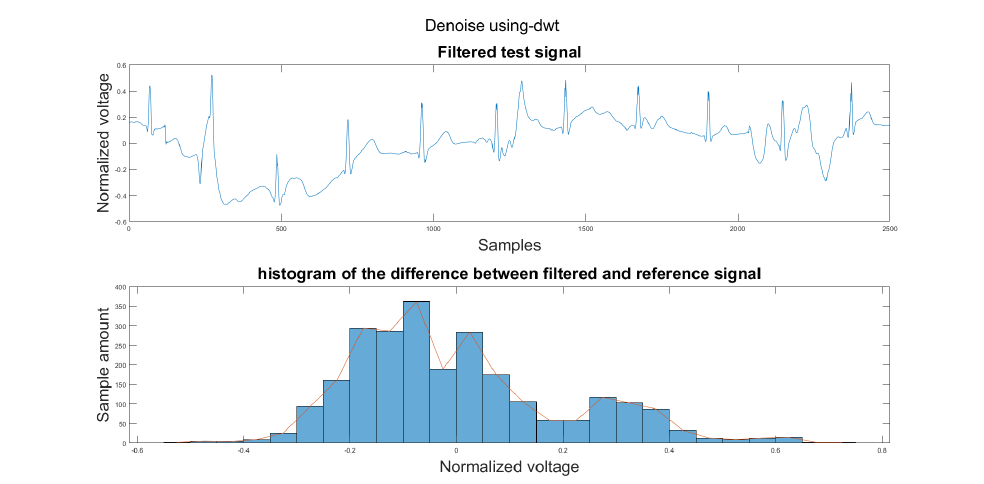
Figure A39. (1) Test signal, (2) histogram of the difference.